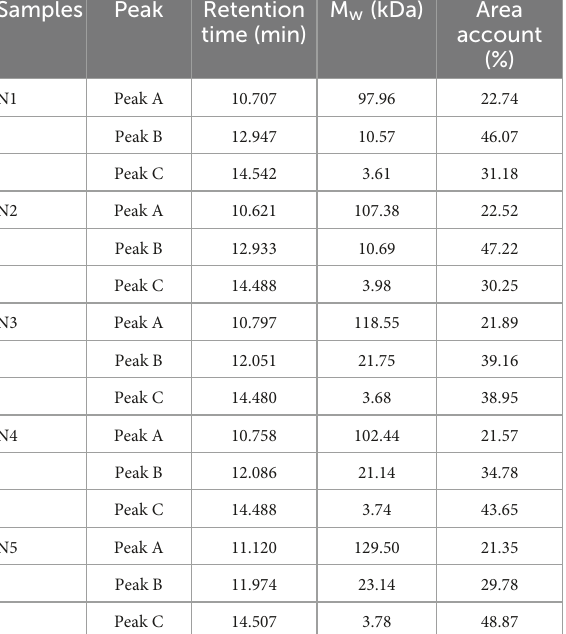
TABLE 2 Retention time, molecular weight (M w ), and amount of soluble polysaccharide fractions from five Noni polysaccharide